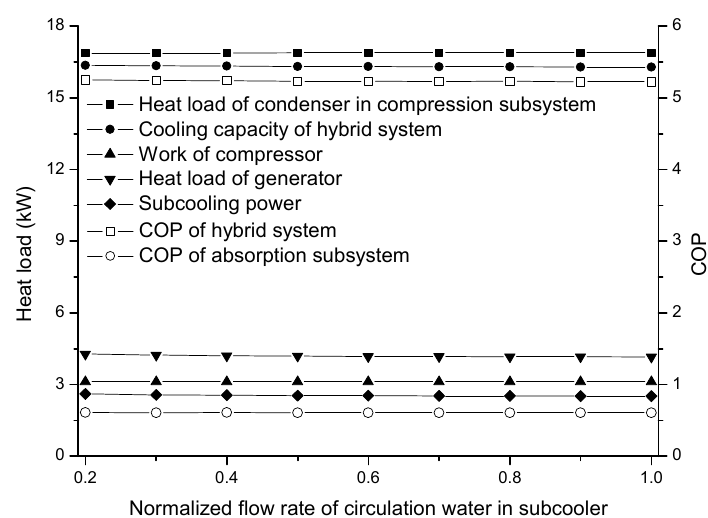
15 of 19 Figure 11. Performance with the flow rate of chilled water. The off-design performance with the flow rate of circulation water in the subcooler is shown in Figure 12. The inlet and outlet temperature of the circulating water is strongly coupled with the corresponding flow rate. The less the flow rate is, the higher the temperature of the circulating water